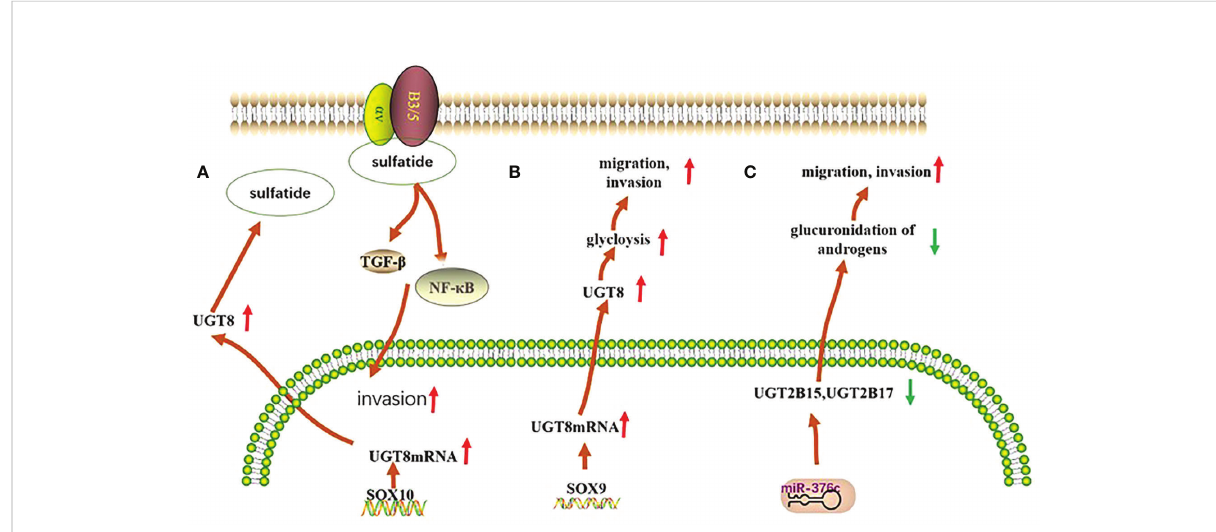
FIGURE 1 Mechanisms of UGTs role in three types of cancer. (A) In basal breast cancer, UGT8 is regulated by SOX10, which promotes the expression of sulfatide and activates the expression of a V b 5 signaling, thereby enhancing the malignancy of basal breast cancer cells; (B) In pulmonary non- small cell lung cancer, UGT8 is regulated by the transcription factor SOX9, which affects the glycolytic process in pulmonary non-small cell lung cancer and plays an important role in maintaining the malignancy of pulmonary non-small cell lung cancer and in poor patient prognosis; (C) In prostate cancer, the expression of both UGT2B15 and UGT2B17 was negatively regulated by miR-376c, with reduced expression leading to their diminished glucuronidation capacity and consequently to increased tumor